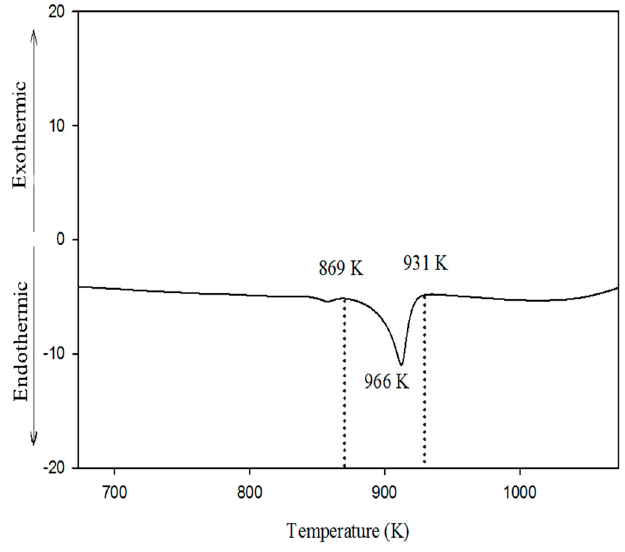
Figure 1. DTA pattern for the A-242 aluminium Figure 1 . DTA pattern for the A-242 aluminium alloy.